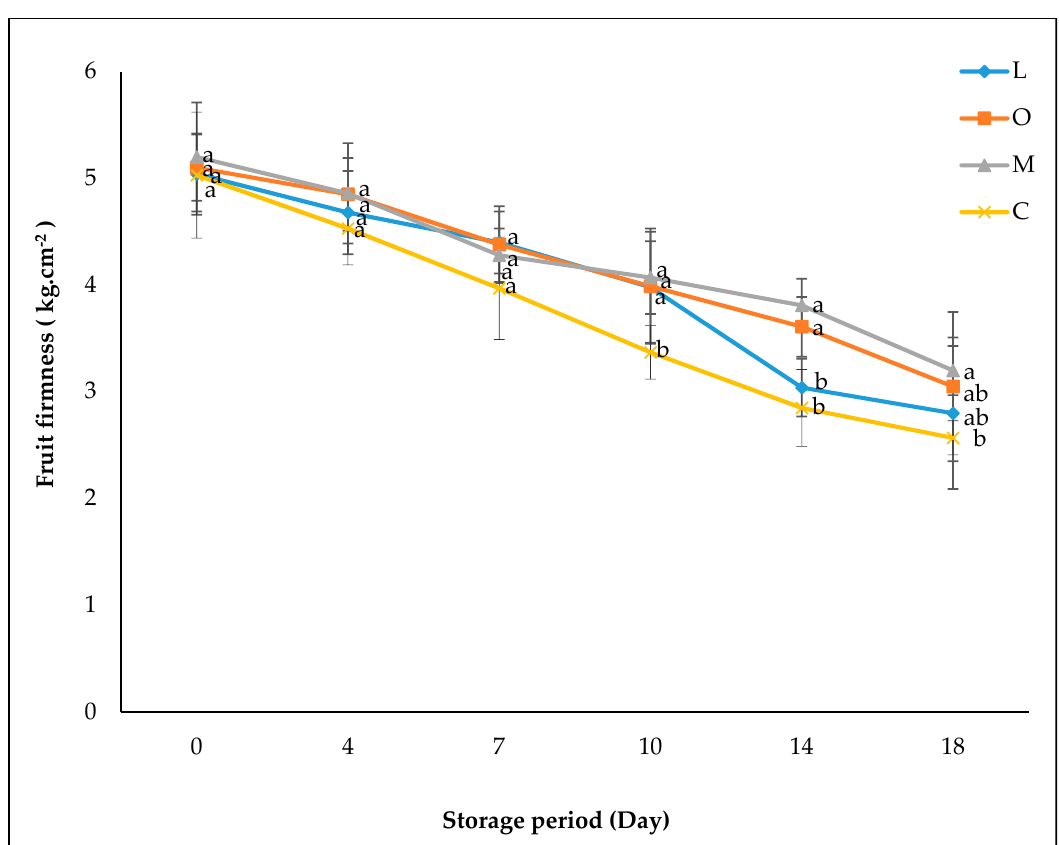
Figure 4. Effect of different essential oil emulsions (L = lemon, O = orange, and M = mandarin essential oil) on firmness of strawberry fruits stored at 2 °C for 18 days. Vertical bars indicate the standard deviation (n = 6). Means and different letters indicate significant difference between treated and control fruits at each storage period (Duncan’s of 95%).